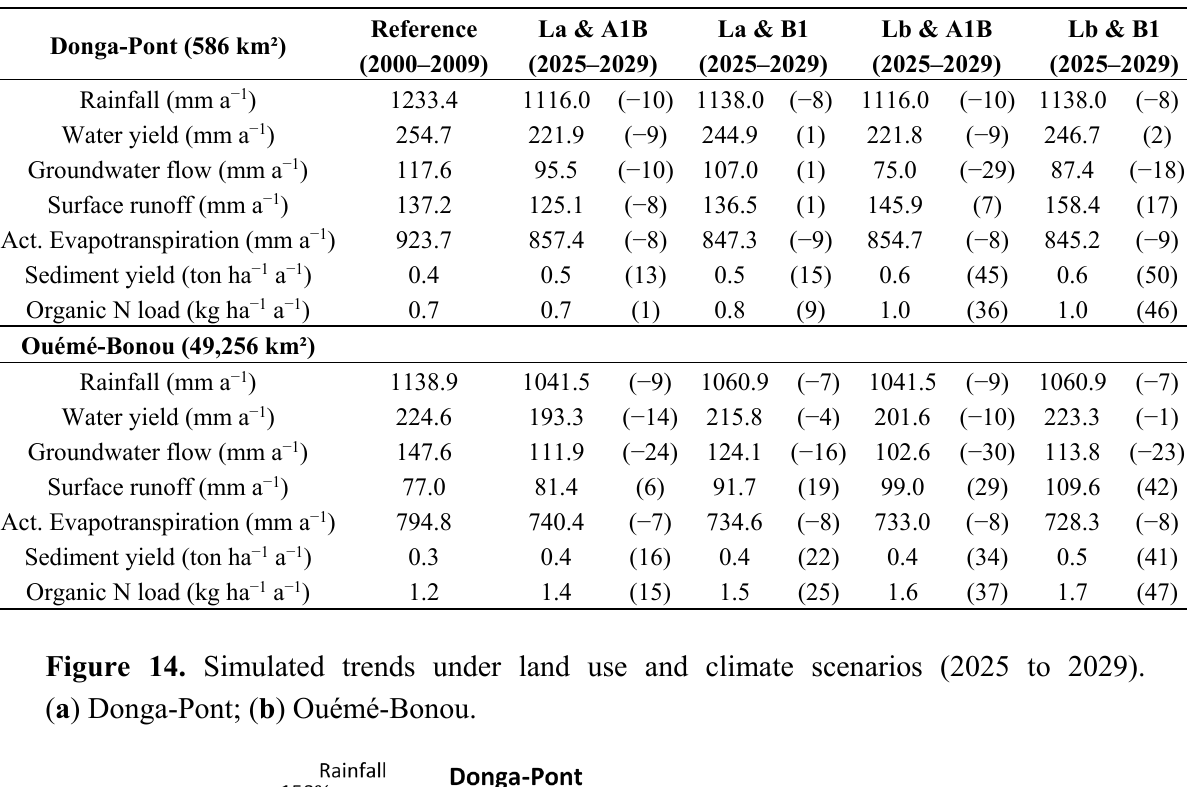
Table 12. Simulated SWAT components under land use and climate scenarios (2025 to 2029). Deviation (in %) from the reference scenario (2000–2009) are shown in brackets.